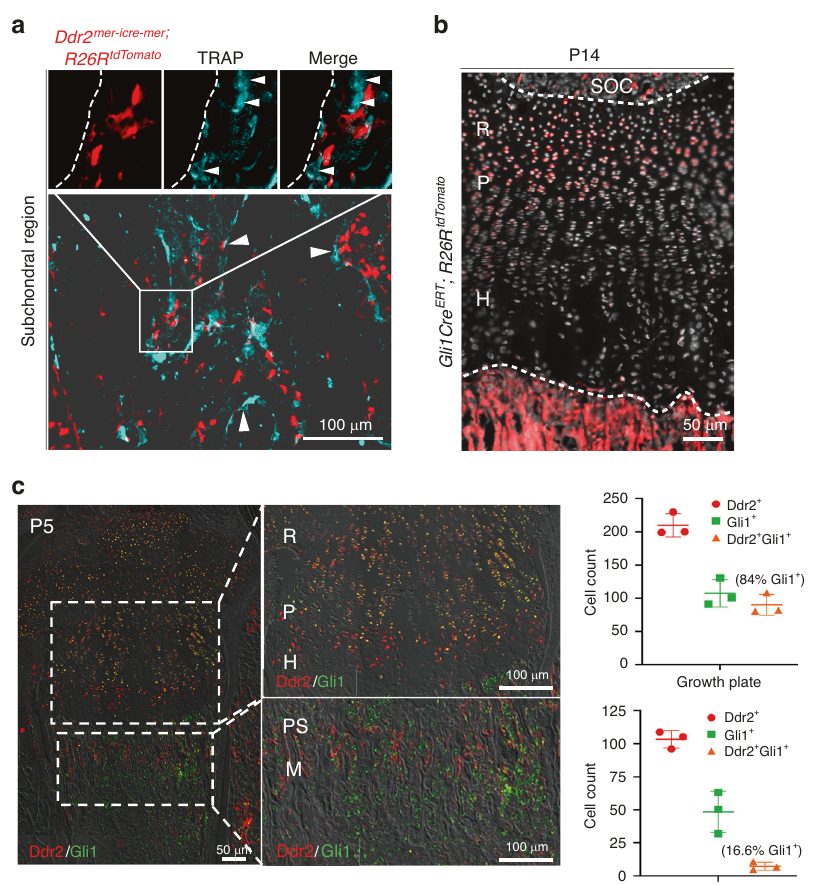
Fig. 3 Ddr2 -derived cells are distinct from osteoclasts; overlapping distribution of Ddr2 and GLI1. a Fluorescence-based TRAP staining on frozen sections from Ddr2 mer-iCre-mer ; R26R tdTomato mice at P14 showing no overlap between TRAP + osteoclasts and Ddr2 tdTomato-labeled cells or their progeny. Scale bar: 50 μ m. Arrowheads indicate multinucleated osteoclasts (Cyan). Dotted Line denotes trabecular bone surface. The boxed region is shown in higher magni fi cation (top). b Gli1-Cre ERT ; R26R tdTomato mice were treated with tamoxifen as in Fig. 2a and examined at P14. Section of the proximal tibia showing Gli1-Cre ERT fl uorescent tdTomato fl uorescence with intense labeling in the resting zone of the growth plate and primary spongiosa, in cell populations having partial overlap with Ddr2 mer-iCre-mer Ddr2- positive cells in Fig. 2. Scale bar: 100 μ m. c IF colocalization of Ddr2 (red) and Gli1 (green). Proximal tibias were isolated from P5 C57BL6 mice. Extensive Gli1 and Ddr2 colocalization were seen in the resting zone (R) and proliferative (P) chondrocytes with low staining in hypertrophic cells (H). More